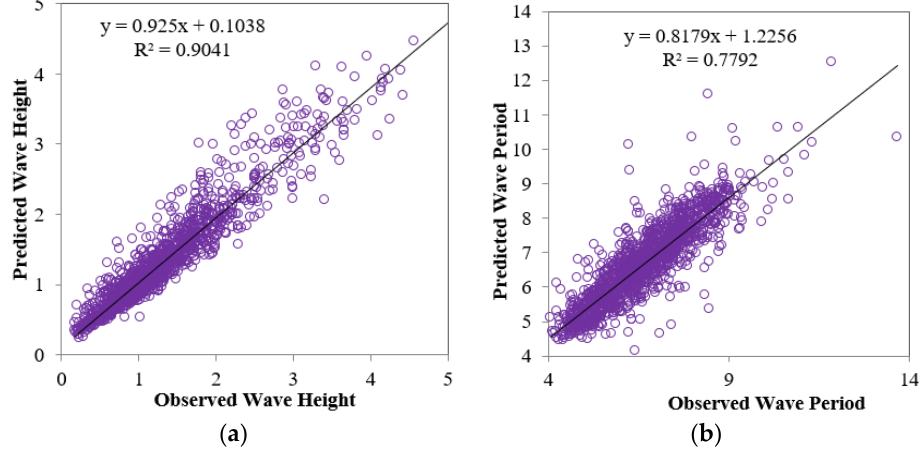
Figure 4. Comparison between the observed and predicted results for the training results of ( a ) wave height and ( b ) wave period.